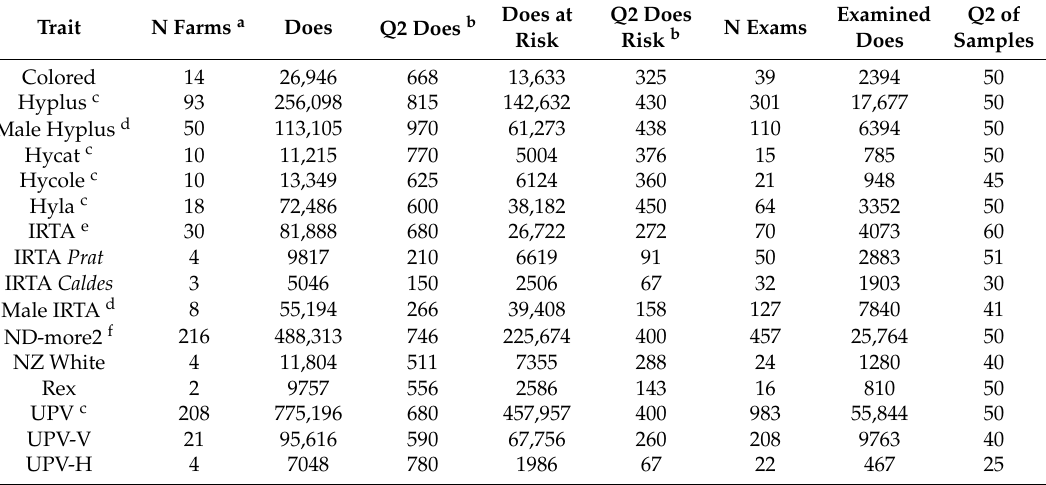
Figure 1. Size distribution of 906 rabbit farms registered in the official census of farms in Spain ( n Rega), in summer 2017, and sizes of 490 study farms with examined does in Spain from 2001 to 2017 ( n sampled). The percentages of sampled farms by strata are shown. Table 1. Overall descriptive traits of the lines of 144,455 rabbit females physically examined on 490 farms in Spain and 41 farms in Portugal from 2001 to 2017.